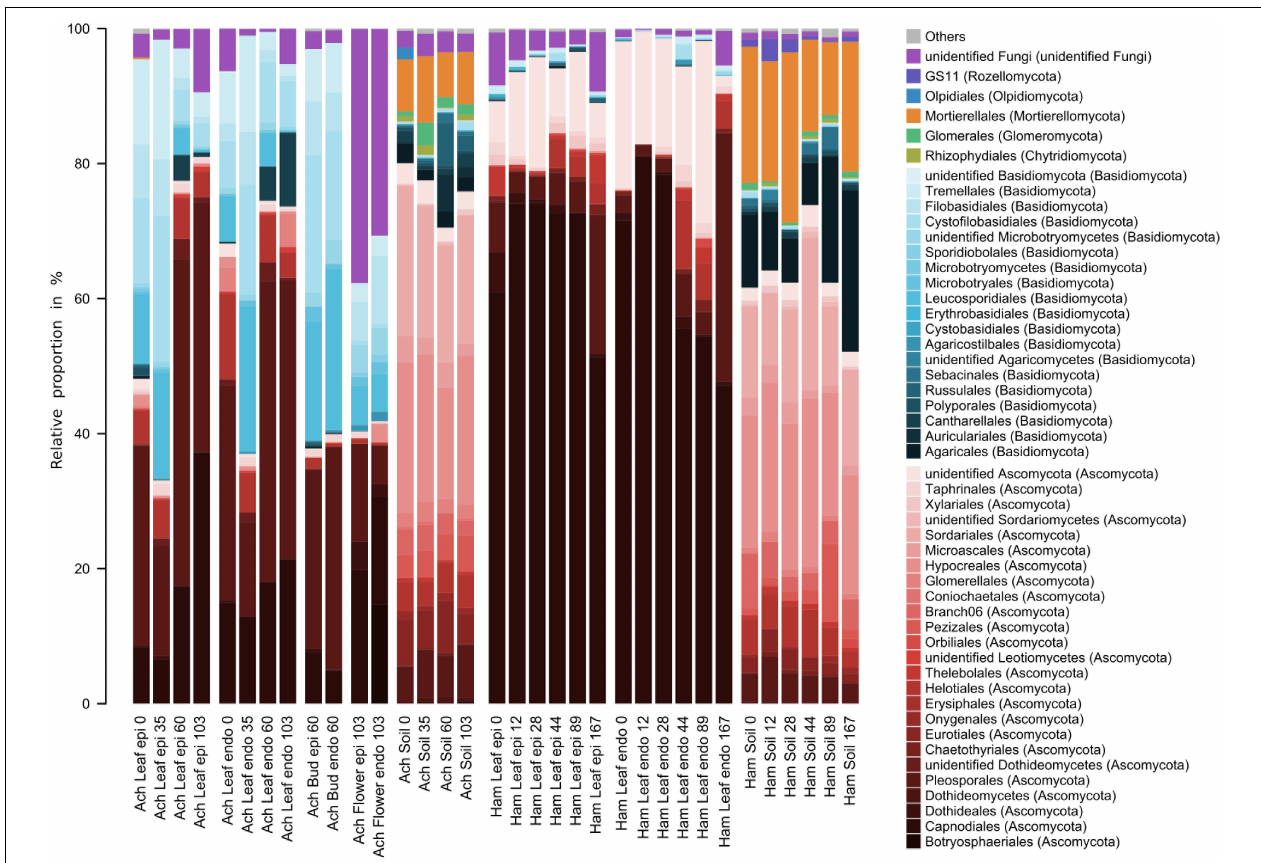
FIGURE 7 | Relative proportions of the 50 most abundant fungal orders of the epi- and endophytic leaf, bud, flower, and soil communities of Achillea (Ach) over a period of 103 days (April to July) and of the epi- and endophytic leaf and soil communities of Hamamelis (Ham) over periods of 89 and 167 days (April to July and September),